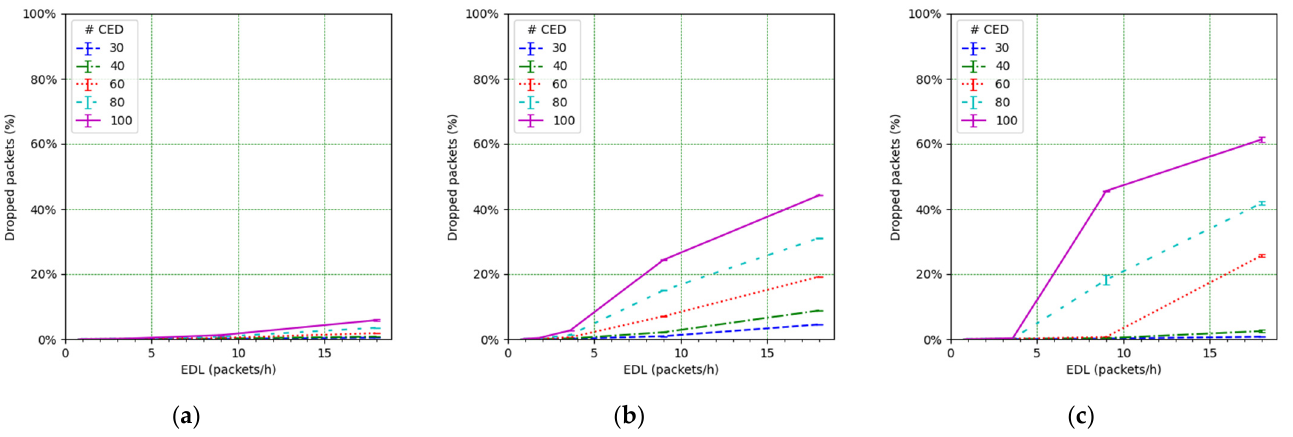
Figure 15. Frame collisions at the gateway vs. EDL for ( a ) SFM1, ( b ) SFM2, and ( c ) SFM3.